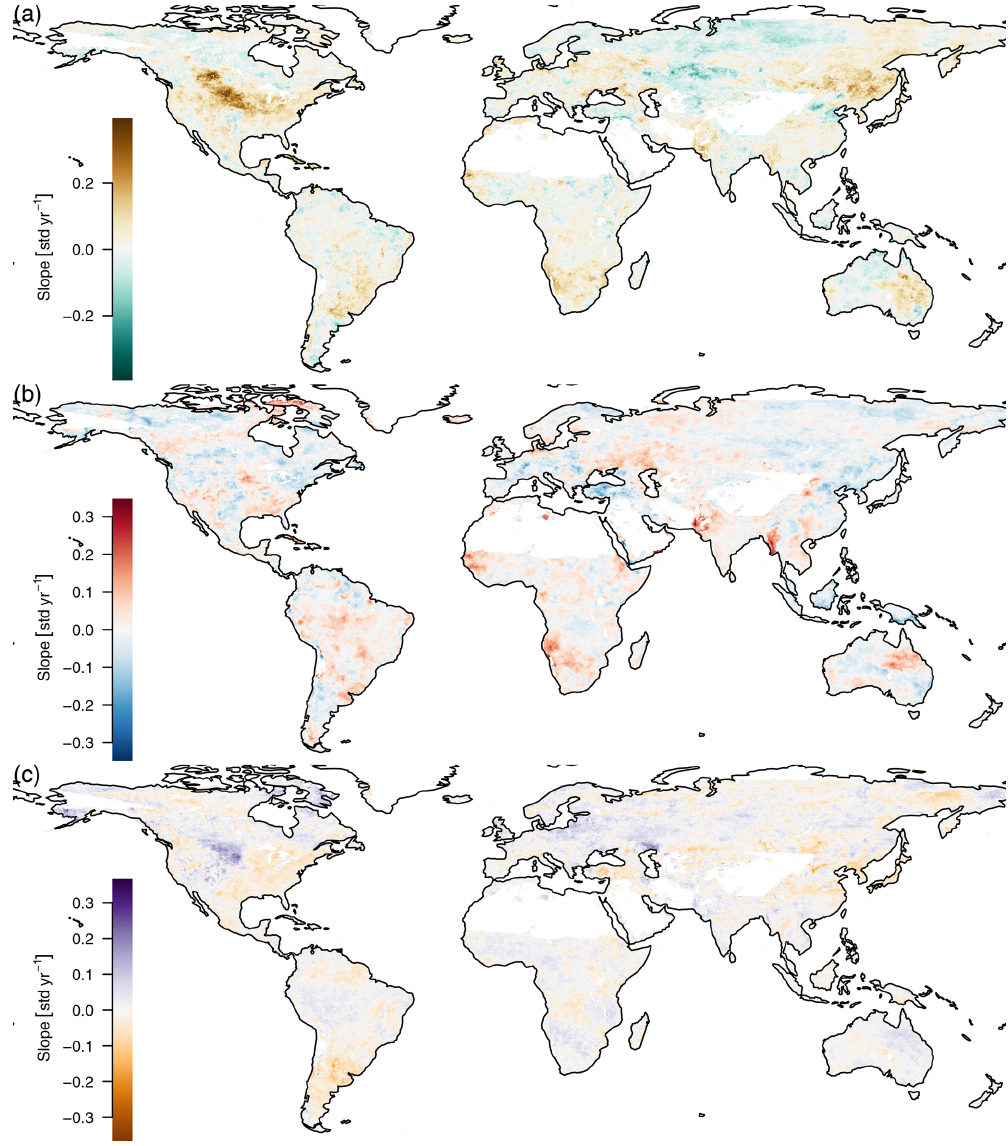
Figure E1. Trends in the amplitude of the yearly cycle, 2001–2011. Only Theil–Sen estimators for significant slopes ( p < 0 . 05, unad- justed ) are shown. Because there is only a single amplitude per year and therefore only 11 data points per time series, the Benjamini– Hochberg adjusted p values are not